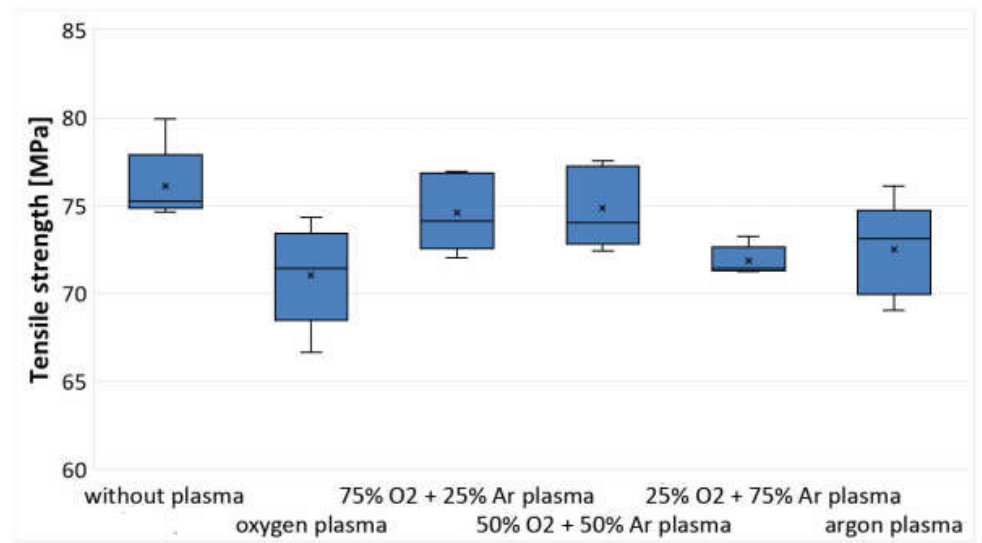
Figure 8. Changes in tensile strength as a result of plasma modification of PLA with different gases and their mixtures (box plot chart for 5 measurements, where: upper whisker—maximum, lower whisker—minimum, box height shows 1st and 3rd quartile and includes median).